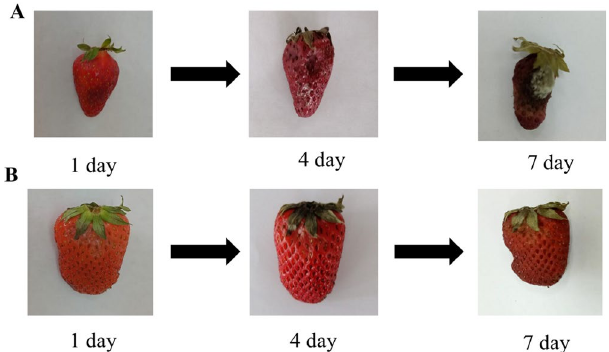
Figure 18. Photo of strawberry samples: ( A ) control sample without nanopackaging, ( B ) experimental sample with